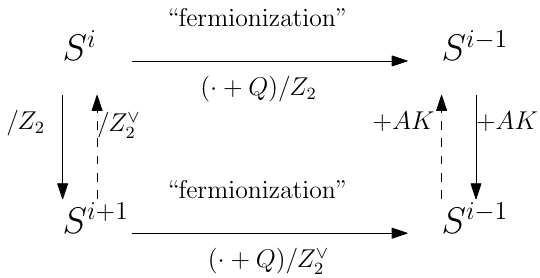
Figure 13 . 6d SCFTs with g = so (8) from three polarizations S i = SO(8) , Sc (8) , Ss (8) for i = 0 , ± 1 mod 3 respectively. These three theories are all dual to one another by triality with the same partition function. The theories on the right are treated as a v -theory by tensoring with trivial 4 v 4 -SPT phase (for a detailed discussion of such SPT phases and their generalizations to 2 n space- time dimension, see [36]), similar to appendix C of [67]. The vertical arrows correspond to changing the polarizations of the 7d three-form Chern-Simons theory. This is a special case of the general relation between gauging Z ( n − 1) -form symmetry and stacking higher fermionic SPT phases in 2 2 n -dimensional space-time discussed in